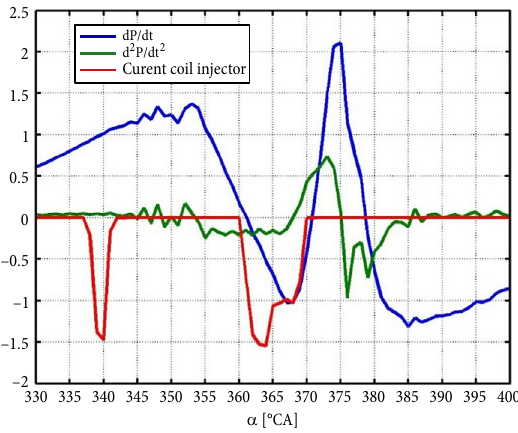
Fig. 14. A juxtaposition of the first and second derivative of pressure in the combustion chamber with injector control current; n = 1500 rpm; T = 200 Nm; U DO = 50% (divided dose of diesel oil)